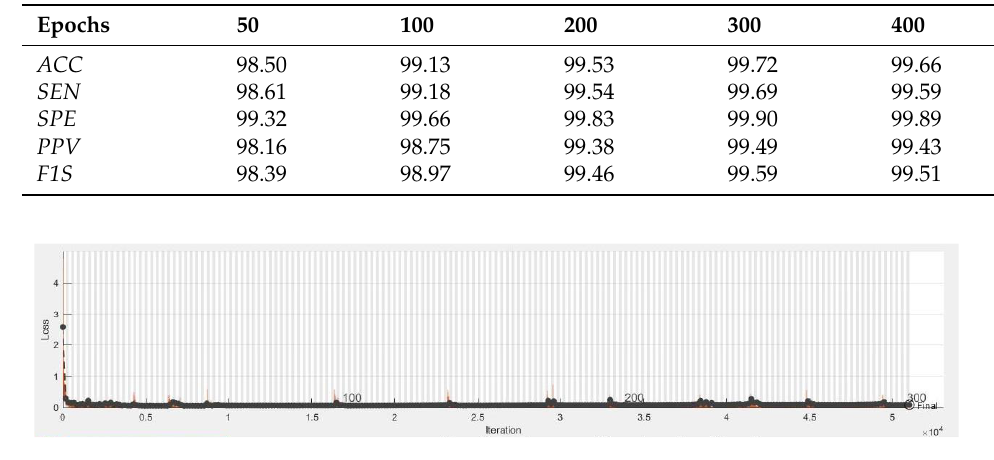
Figure 10. The representation of the loss function values during training the network using 300